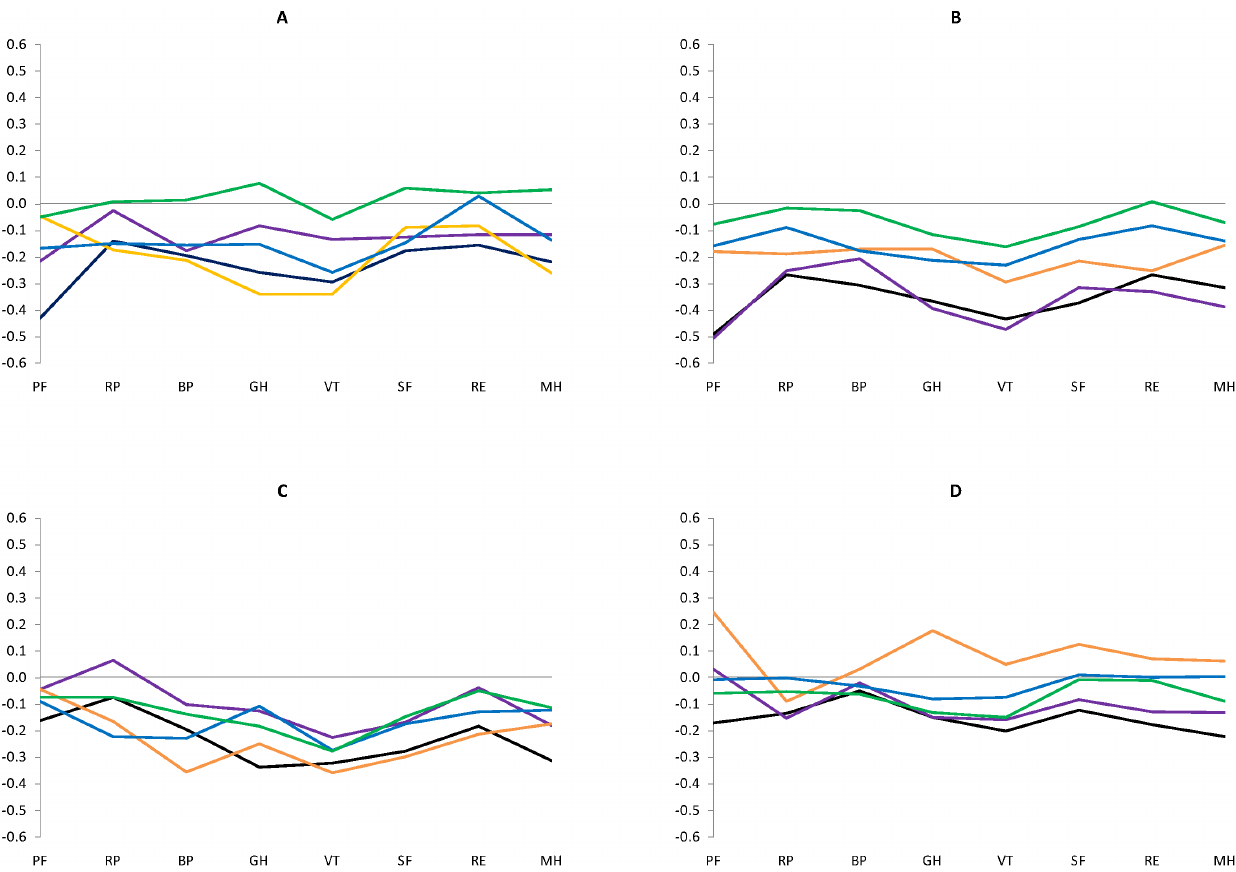
Figure 2. Standardized SF-36 scale scores according to smoking status: current daily smokers (black), occasional smokers (purple), occasional ex-daily smokers (orange), ex-smokers (blue), never smokers (green). Panel A, men 25–44 yrs; Panel B, men 45–64 yrs; Panel C, women 25–44 yrs; Panel D, women 45–64 yrs. PF physical functioning; RP role limitations due to physical problems; BP bodily pain; GH general health; VT vitality; SF social functioning; RE role limitations due to emotional problems; MH mental health.